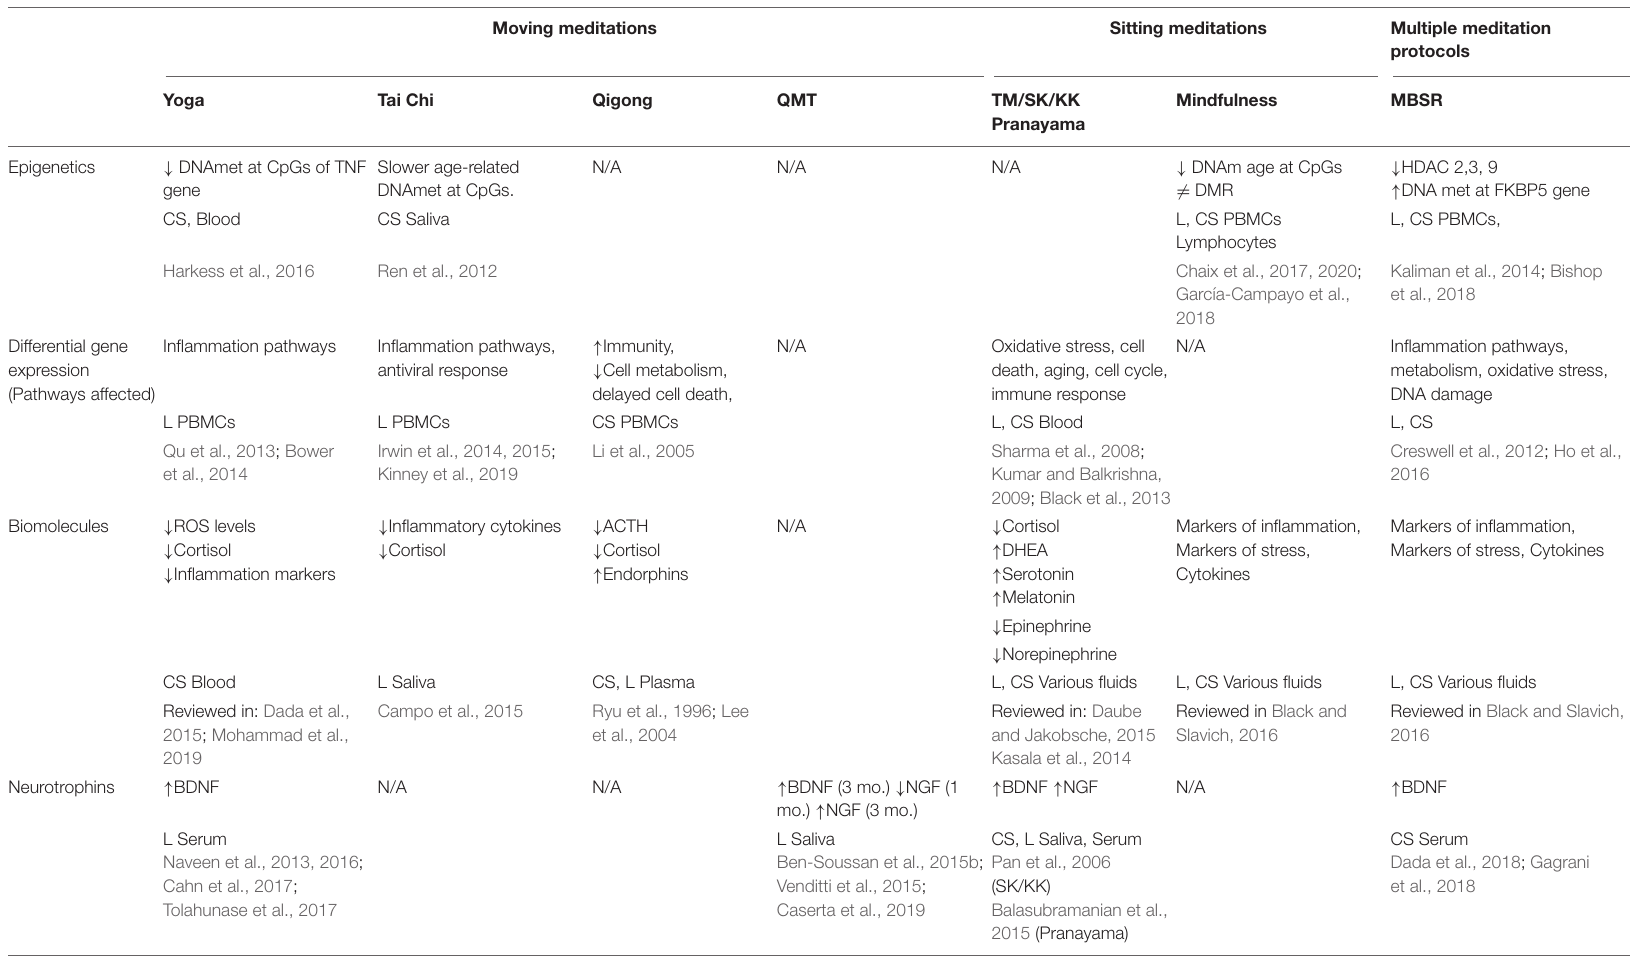
TABLE 1 | Side-by-side summary of the effects of different meditations. Moving meditations Sitting meditations Multiple meditation